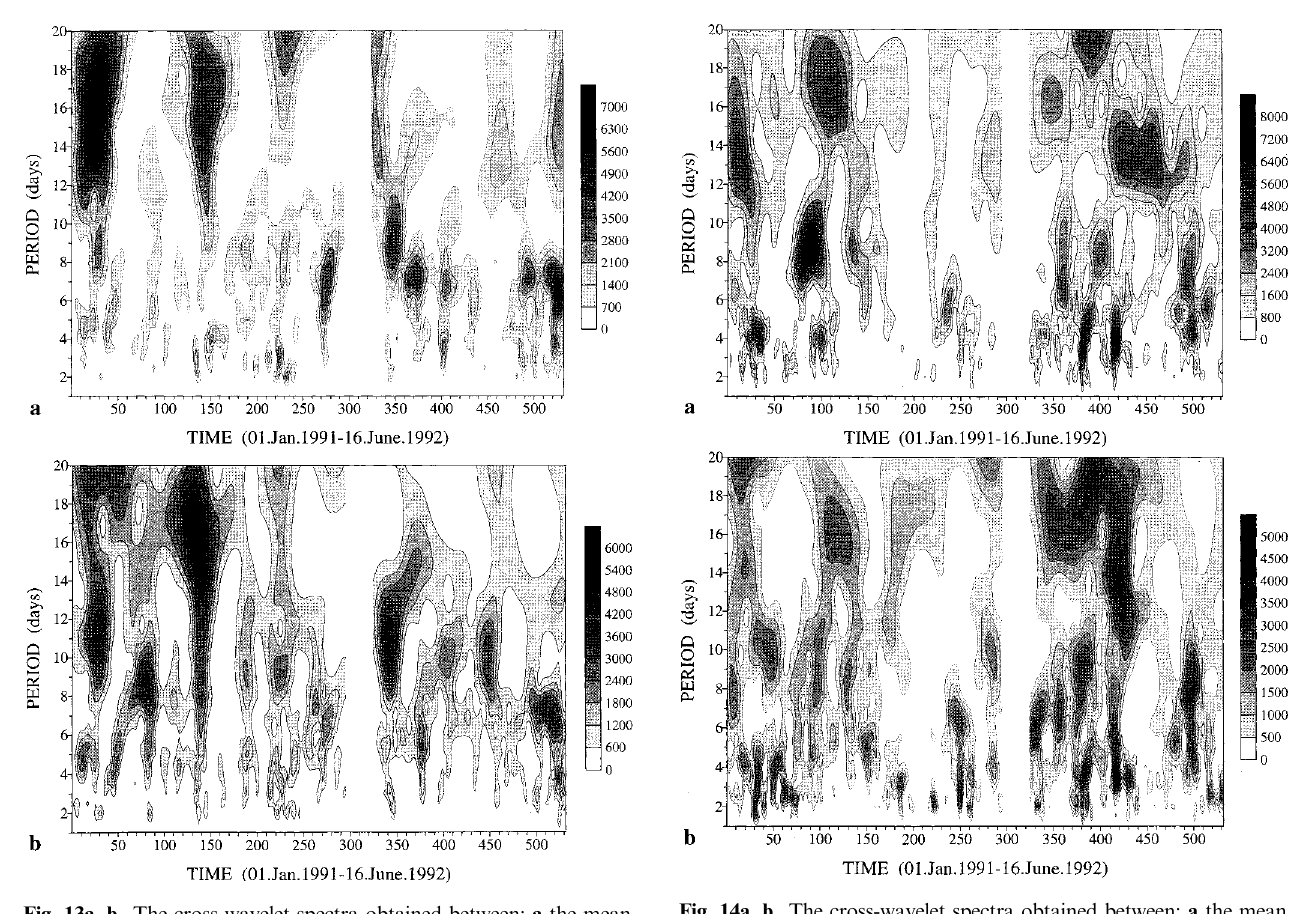
Fig. 13a, b. The cross-wavelet spectra obtained between: a the mean zonal wind and the amplitudes of the semidiurnal zonal tide, and b the mean zonal wind and the amplitudes of the diurnal zonal wind